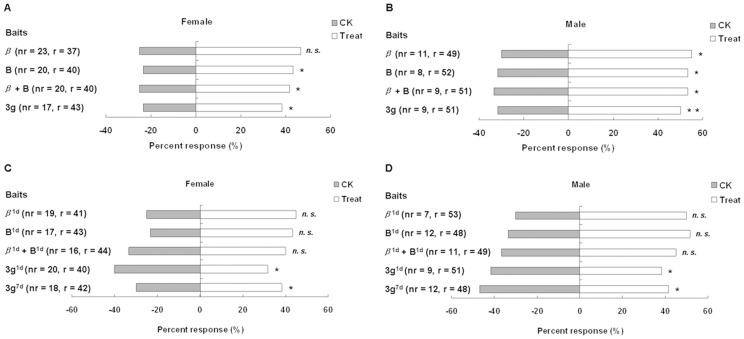
Choices of adult A. lucorum in the Y-tube olfactometer.(A) female towards pure β-ionone, benzaldehyde, β-ionone + benzaldehyde and 3 g, (B) male towards pure β-ionone, benzaldehyde, β-ionone + benzaldehyde and 3 g, (C) female towards β-ionone1d, benzaldehyde1d, β-ionone1d + benzaldehyde1d, 3g1d and 3g7d, (D) male towards β-ionone1d, benzaldehyde1d, β-ionone1d + benzaldehyde1d, 3g1d and 3g7d. The bars represent the percentage of tested insects that made a particular choice. The asterisks with the choice bars indicate significant preferences. *P<0.05, **P<0.01, n.s.  =  not significant, nr  =  not reacting, r =  reacting. Superscript characters of compounds represent the periods that the chemicals left exposing to air and sunlight.